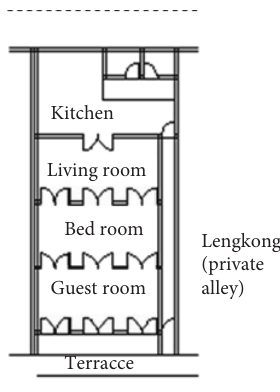
Figure 13. Dominant doors in the fasade of Omah (source: observation,